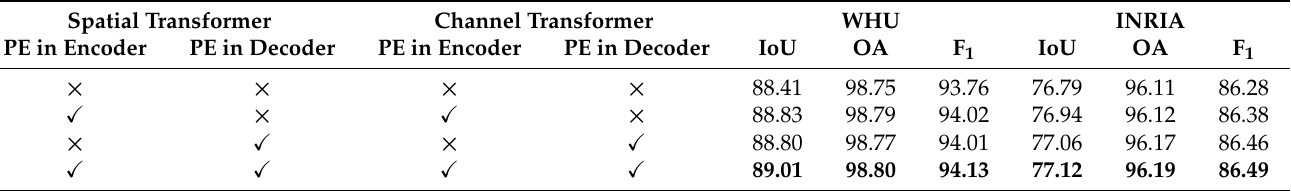
Table 6. Ablation study of the position embeddings ( PE ) in the spatial and channel transformer on the two datasets. The evaluation is conducted on both the transformer encoder and the transformer decoder. Spatial Transformer Channel Transformer PE in Encoder